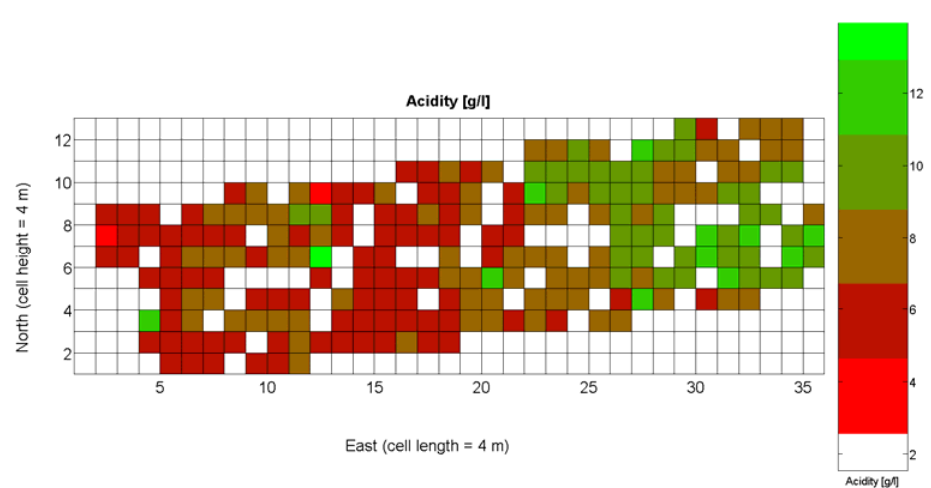
Figure 12. CB map of must acidity (g/L).